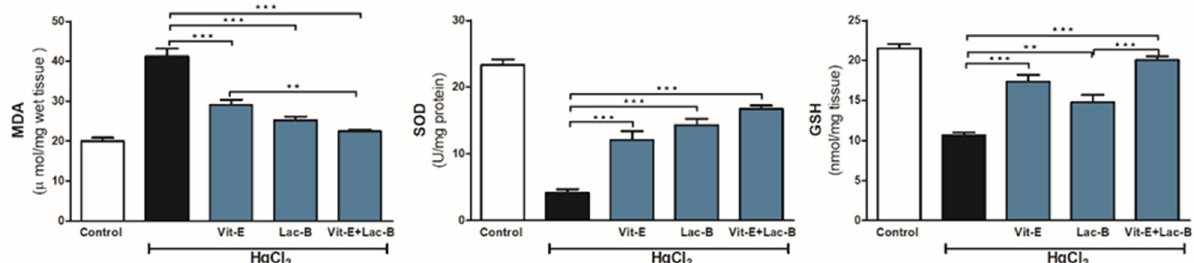
Figure 2. Vit-E and Lac-B attenuated HgCl 2 -induced renal injury in rats. Treatments with Vit-E and Lac-B either alone or in combination decreased renal MDA and increased GSH and SOD. Data are expressed as mean ± SEM, ( n = 6). ** p < 0.01 and *** p < 0.001.